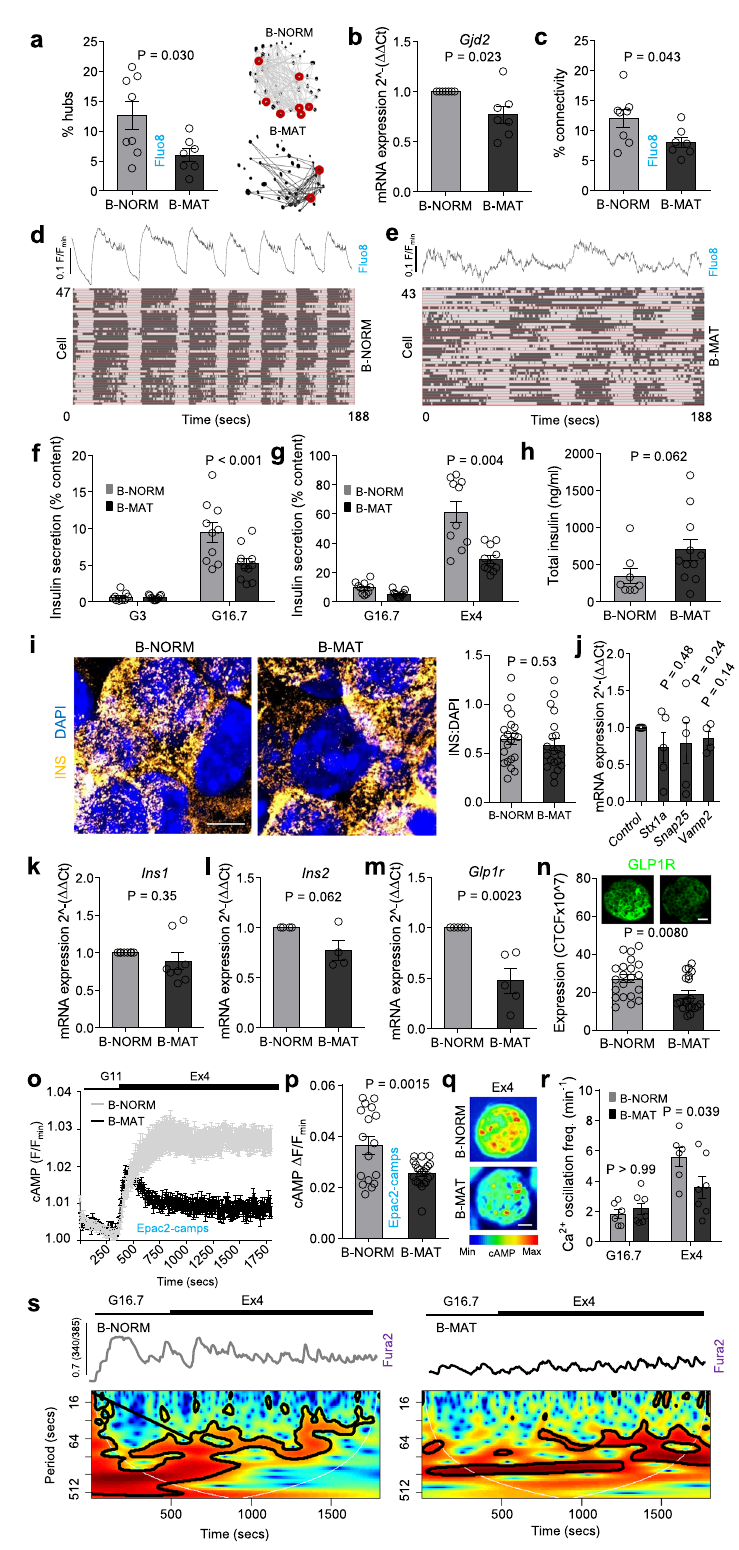
mutant muscarinic receptor with low af fi nity for endogenous acetylcholine 40 . Upon administration of designer ligand, the G i pathway is activated speci fi cally in β -cells, leading to long-lasting electrical silencing via effects on cAMP and G protein-coupled inwardly-rectifying potassium channels 40,41 . We used